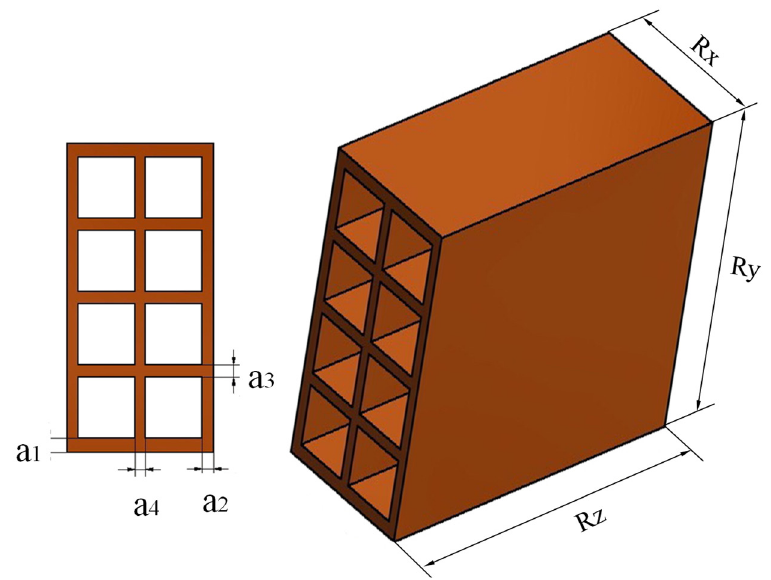
Figure 2. Scheme of the brick used in the research.